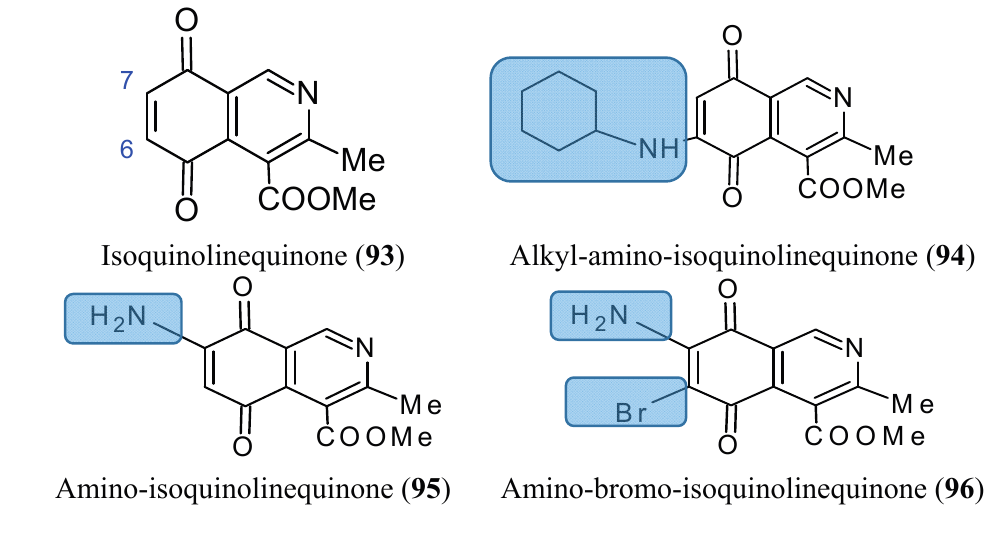
Figure 33. Aminoquinones and derivatives 93 – 96